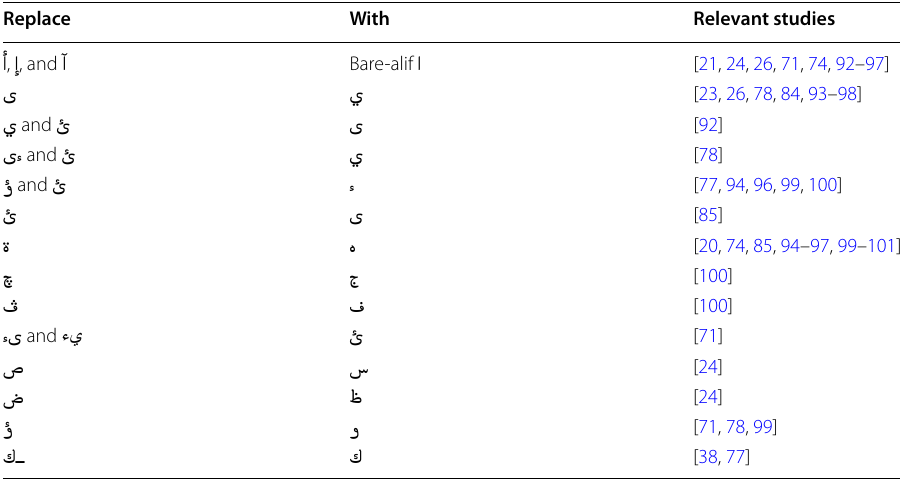
Table 2 Normalization techniques used by different researchers